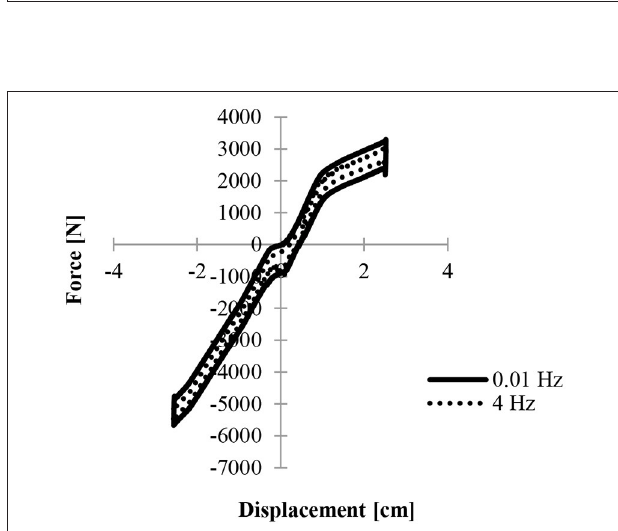
FIGURE 10 | Force displacement curves for seal friction in the quasistatic (0.01Hz) and dynamic (4Hz) regions indicating that seal friction does not dramatically increase with